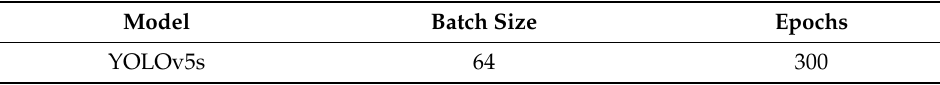
Table 3. The parameters of the training model.